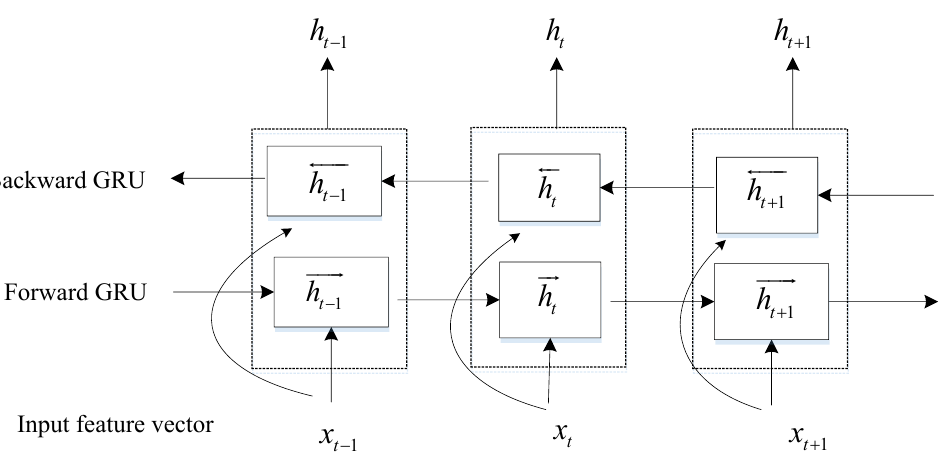
Figure 10. BiGRU structure diagram.